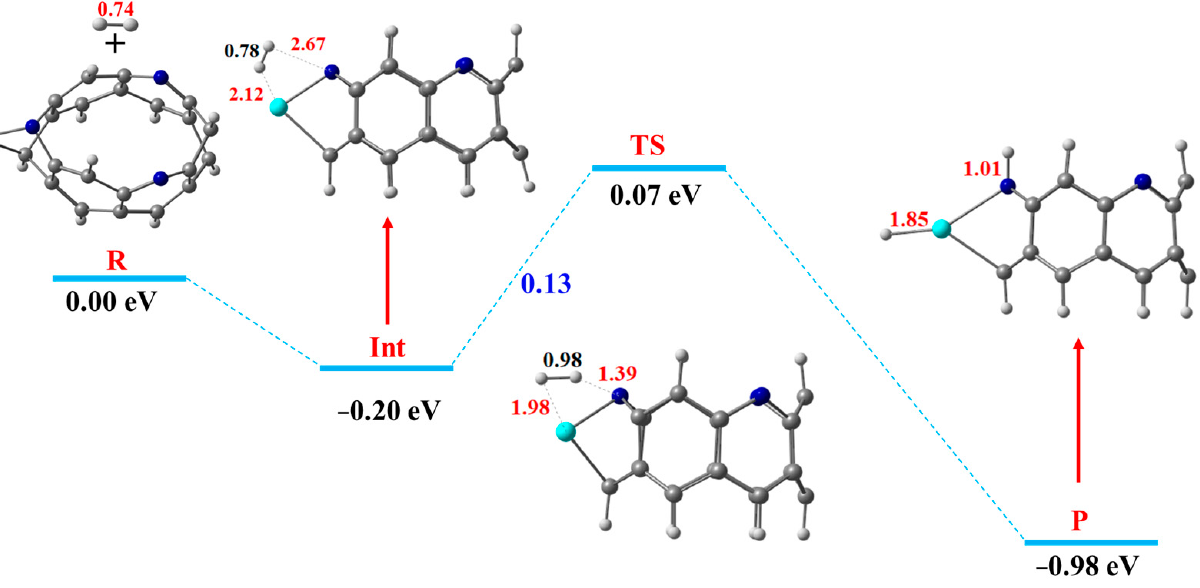
Table 3. NBO charge transfer analysis of stable H 2 TM@NB complexes.